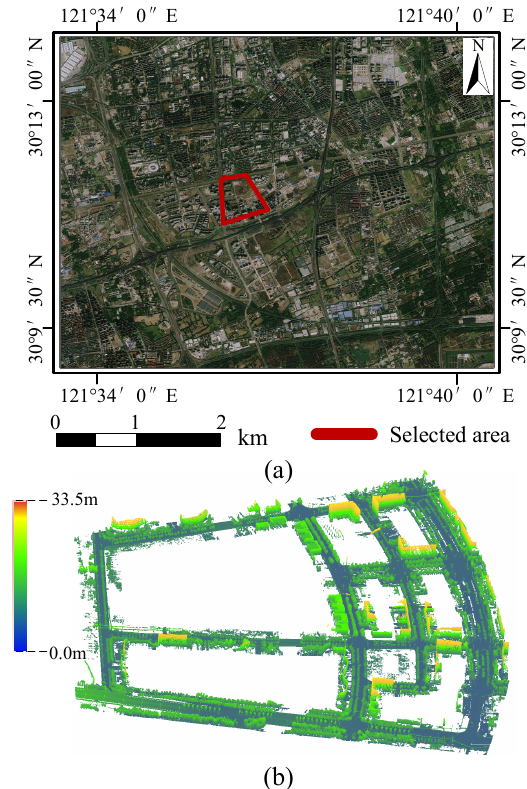
Figure 6 . Sketch of the case area: (a) Location of the case area, (b) MLS point